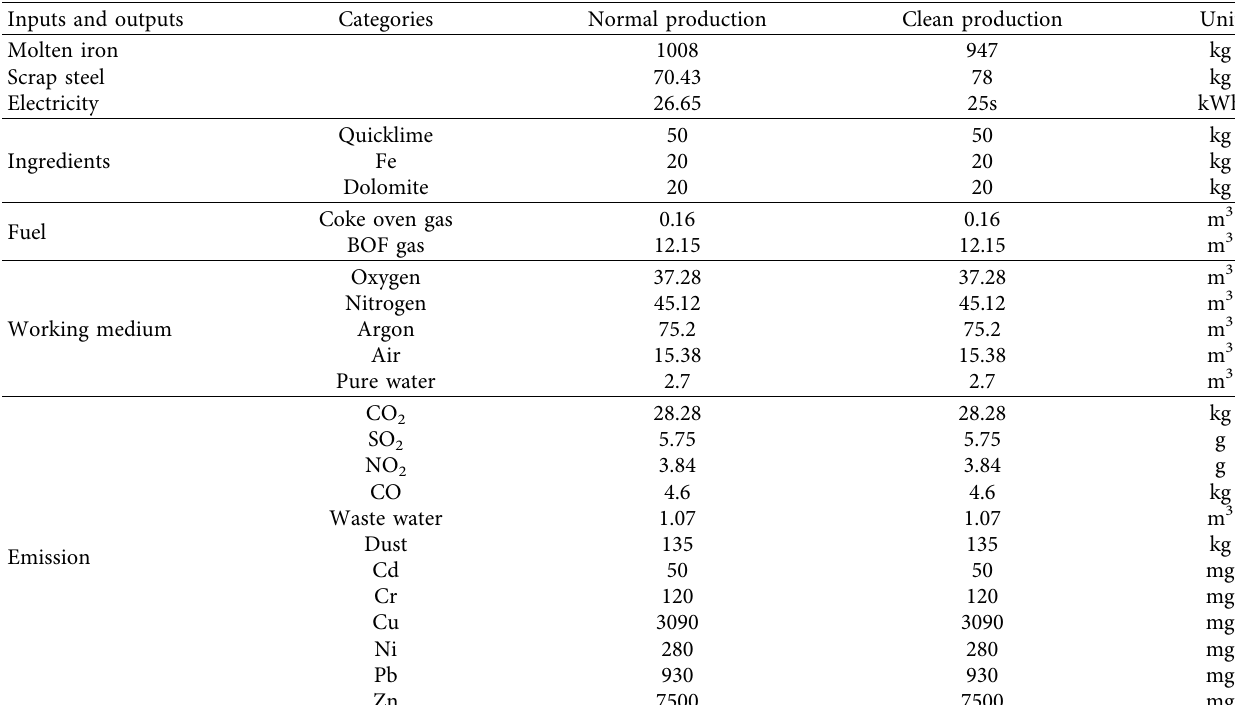
Figure 1: Simplified scheme of iron and steel production routes and Table 1: Life cycle inventories of molten steel. Value are presented per ton.